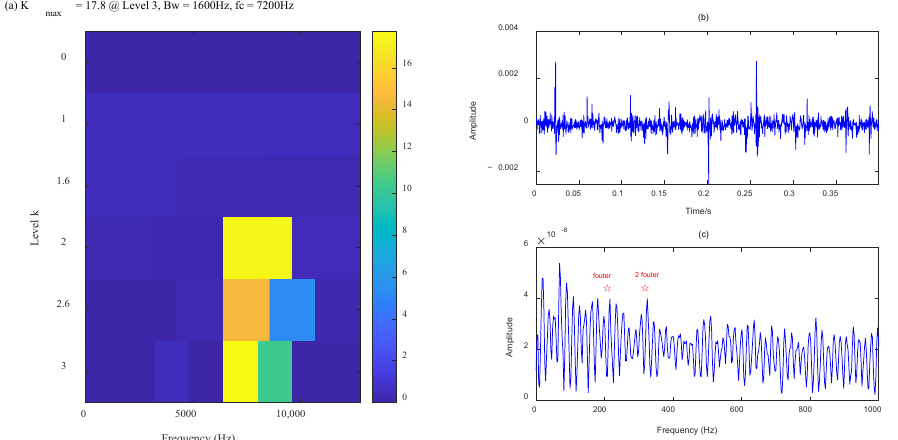
Figure 24. Processing 2100 r/min outer race fault signal with Fast Kurtogram: ( a ) Kurtogram diagram, ( b ) Filtered signal, and ( c ) its square envelope spectrum.